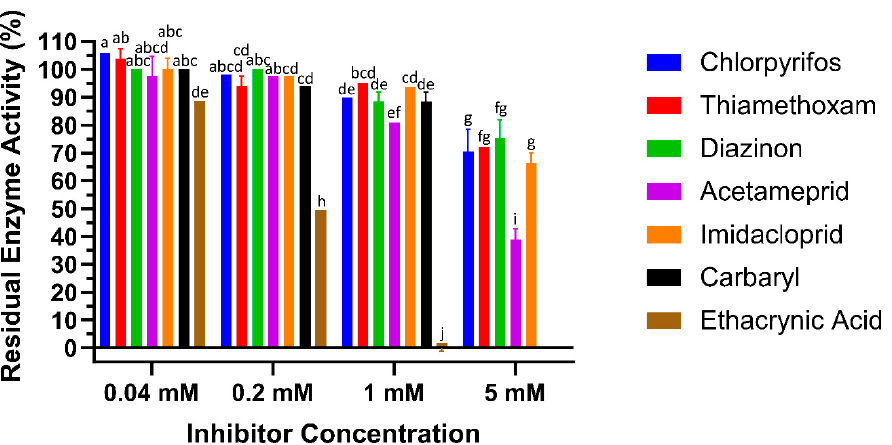
Figure 6. Inhibition of LdGSTu1 with ethacrynic acid (EA) and pesticides. Data points are means of independent triplicate experiments. Error bars are the calculated standard deviations of the independent triplicate experiments. Columns are color coded (see the key on right for representative colors) for the inhibitors screened and grouped into four concentrations from left to right 0.04, 0.2, 1, 5 mM. Statistical significance of residual enzyme activity among treatments was calculated using one-way ANOVA, followed by a Turkey’s HSD multiple comparation test. There was no significant difference among treatments with the same alphabetic letters (e.g., a, b, and c).